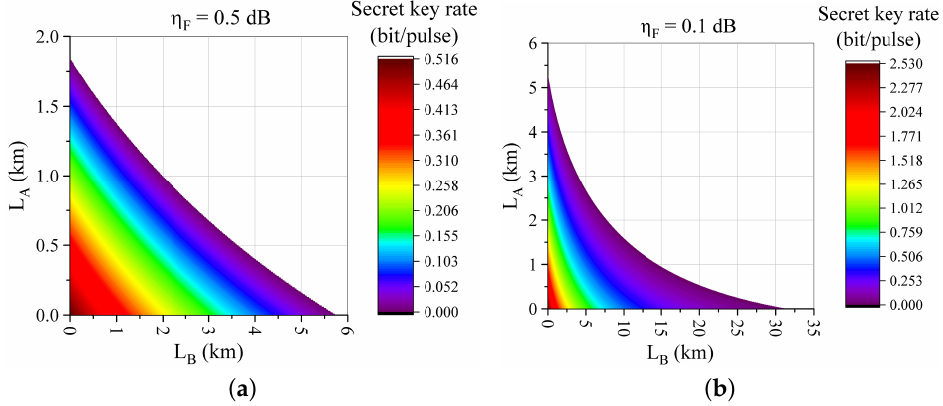
Figure 6. The secret key rate of one core for the multi-core-based MDI CVQKD protocol. ( a ) η F = 0.5 dB. ( b ) η F = 0.1 dB. η F is the insert loss of the FIFO. Alice and Bob’s modulation are much larger than 1. L A is the distance between Alice and Charlie. L B is the distance between Bob and Charlie.